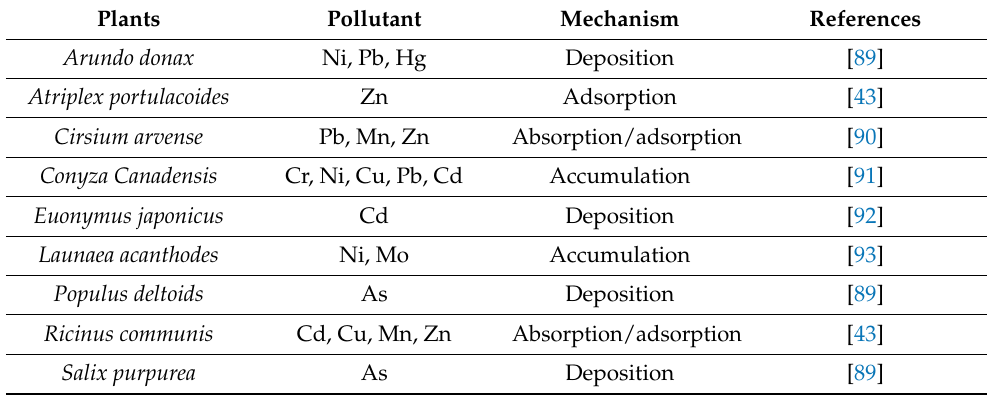
Table 5. Suitable plant species for